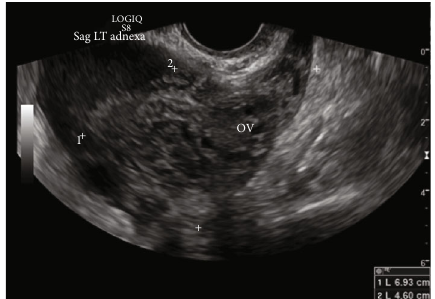
Figure 1: Transvaginal ultrasound image of left adnexa. OV depicts ovarian tissue. Complex left adnexal mass measuring 6 : 9 × 4 : 6 × 4 : 7cm 3 .